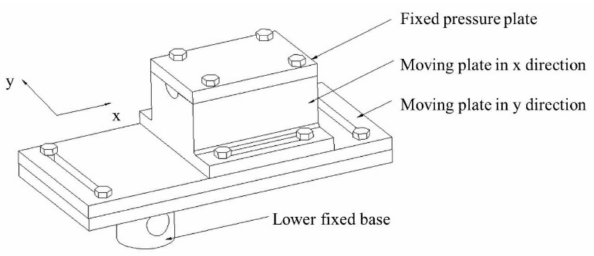
Figure 4. Shearing platform of universal tester.